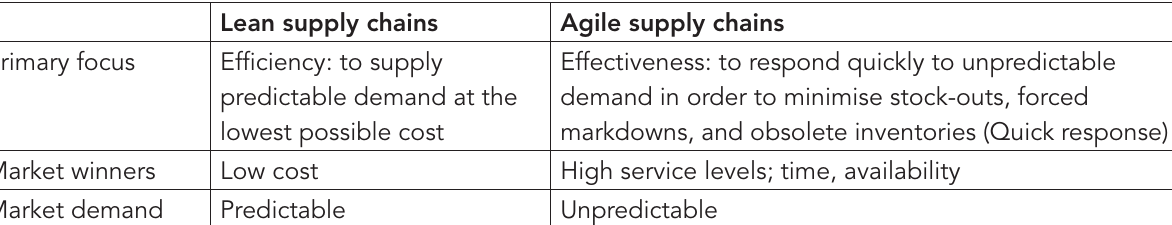
Table 1: Characteristics of lean and agile supply chain strategies Source: Adapted from Bruce et al . (2004); Christopher